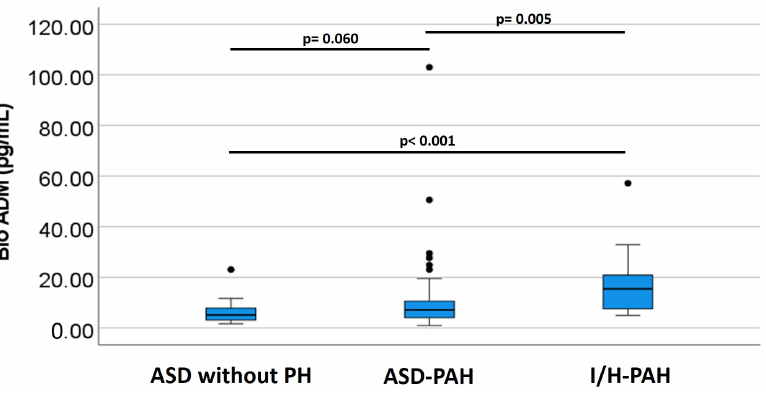
Figure 1. The bio-ADM levels of the groups. The highest bio-ADM level was observed in subjects with I/H-PAH, followed by those with ASD-PAH. ASD without PH was the control group. The Mann–Whitney test: ASD without PH vs. ASD-PAH, p = 0.060; ASD without PH vs. I/H-PAH, p < 0.001; ASD-PAH vs. I/H-PAH, p = 0.005.